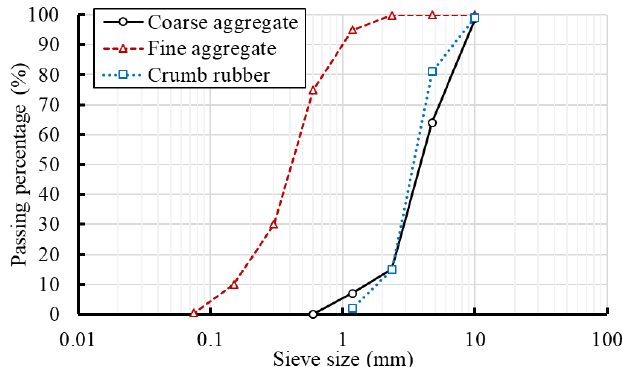
Figure 1. Particle size distributions of the aggregates and the CR.